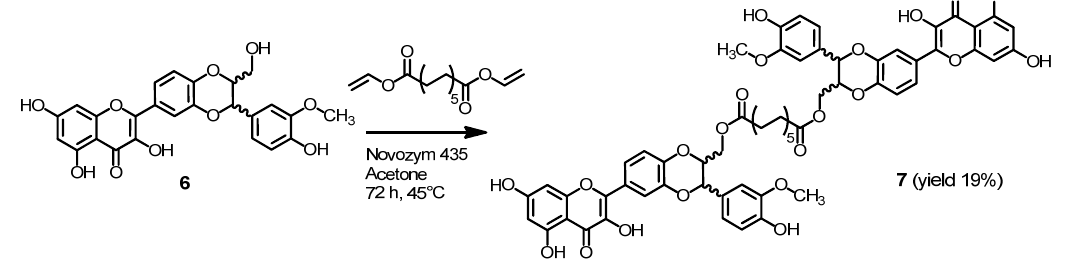
Scheme 3. Synthesis of silybin dimers with ether